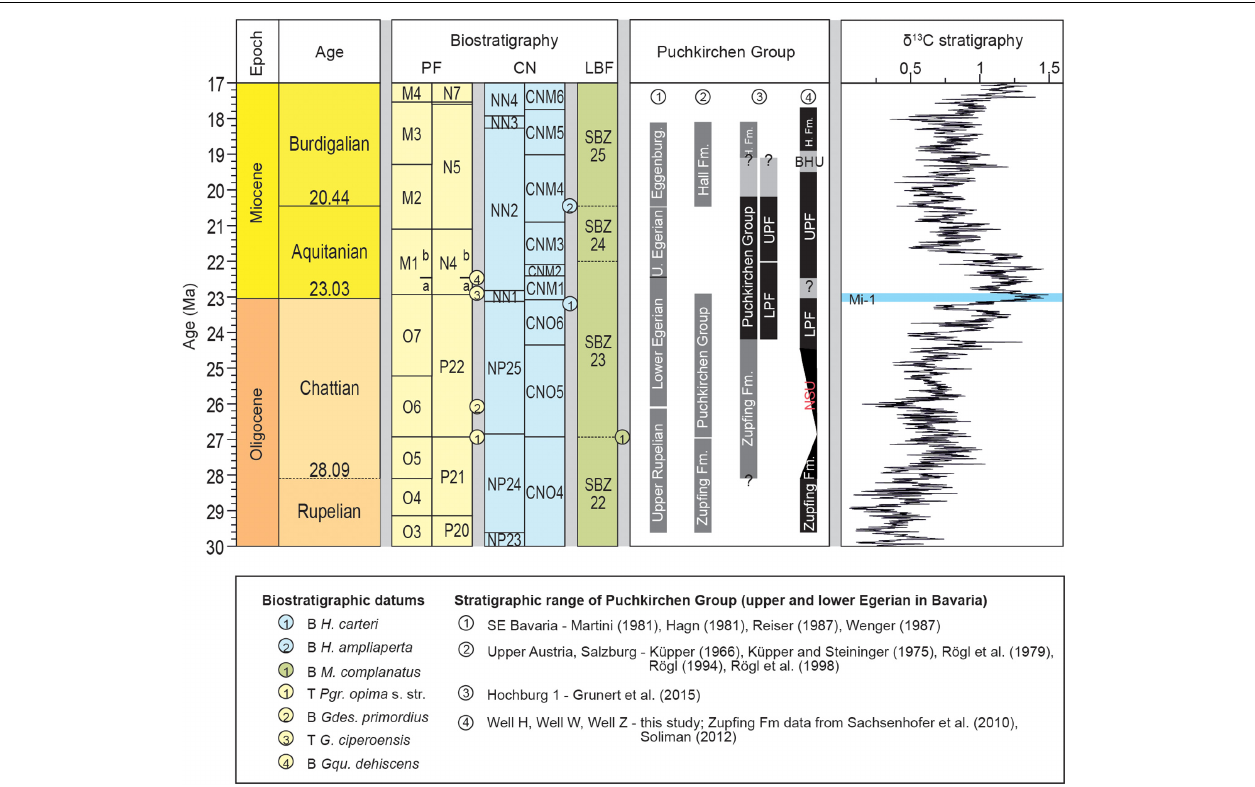
FIGURE 12 | Summary of the proposed stratigraphic concepts (number 1, 2, 3) of the Puchkirchen Group and the concept presented here (4). Planktonic foraminifera (PF) zonation follows Wade et al. (2011) and Gradstein et al. (2012); calcareous nannoplankton (CN) zonation follows Backman et al. (2012); Gradstein et al. (2012), and Agnini et al. (2014); larger benthic foraminifera zonation follows Cahuzac and Poignant (1997) and Gradstein et al. (2012). Global δ 13 C stack from Cramer et al. (2009). Gray bars indicate uncertainties, BHF summarized as BHU. See text for details. Redrawn after Grunert et al. (2015).